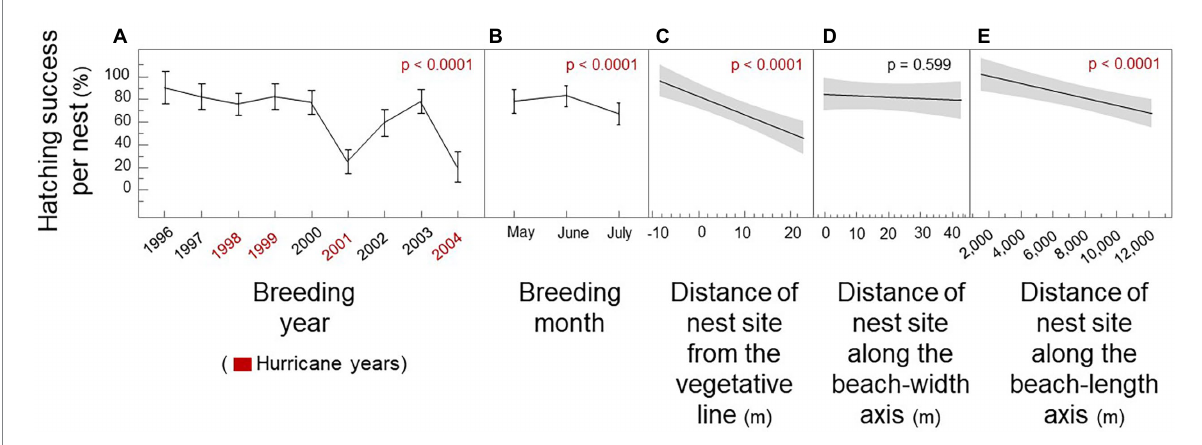
FIGURE 2 Hatching success per nest by spatiotemporal nest site choice of loggerhead females. Breeding year, breeding month, nest sites, and emergence sites. (A) Hatching success by breeding year (B) Hatching success by breeding month, independent of year. (C) Hatching success by the distance of the nest site from the line of vegetation. (D) Hatching success by the distance of the nest site along the beach-width axis starting from the high water line. (E) Hatching success by the distance of the nest site along the beach-length axis from a permanent marker. Hurricane years are shown as blue; mean shows as breaks in the line; SE shows as whiskers; regression line with 95% confidence intervals are shown in